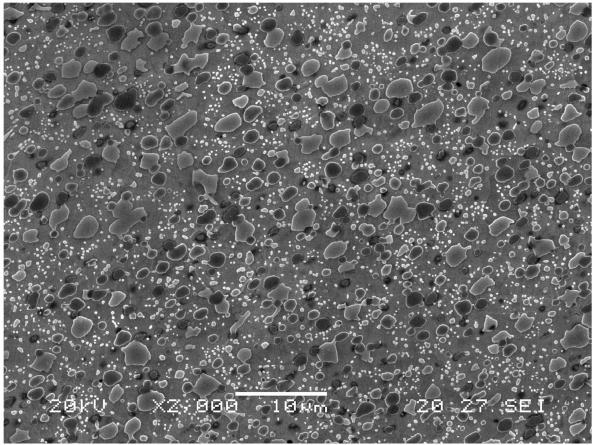
Figure 1. Micrograph of the Vanadis 10 steel in the annealed state. Image was obtained by scanning electron microscope